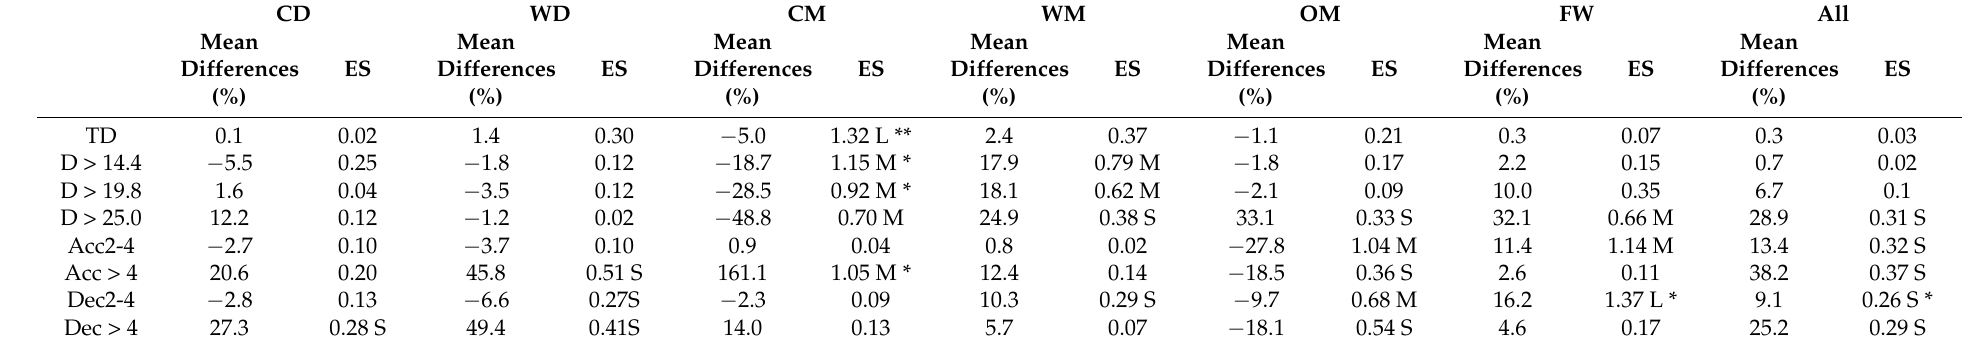
Table 3. Mean differences (%) and effect sizes (ES; ± CL) of the physical demands (mean ± SD) encountered by soccer players for each playing position and for all players between the 1-4-2-3-1 and 1-4-4-2 diamond playing formations. CD WD FW All Mean Differences ES (%)